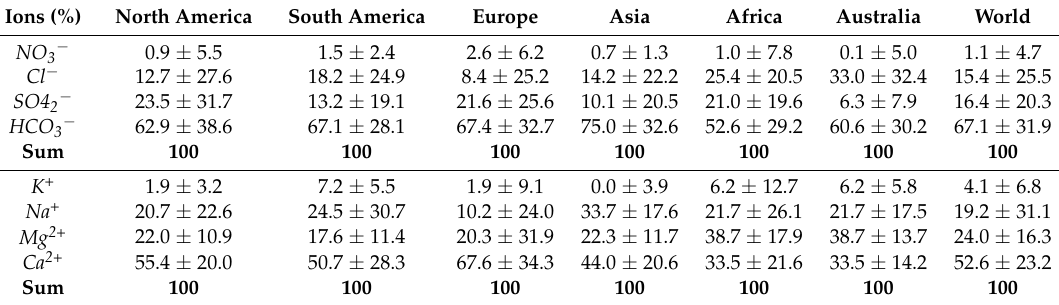
Table 5. Average relative concentrations of major ions as a percentage